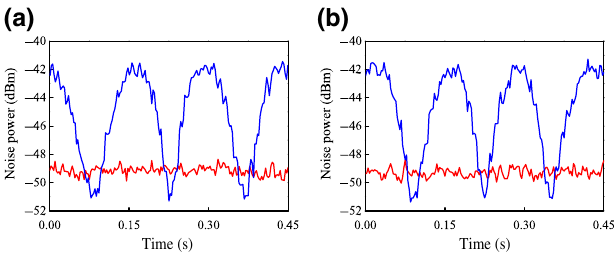
FIG. 5. Noise levels in log scale measured by homodyne detection as a function of phase scan when the SU(1,1) inter- ferometer is (a) balanced and (b) unbalanced,